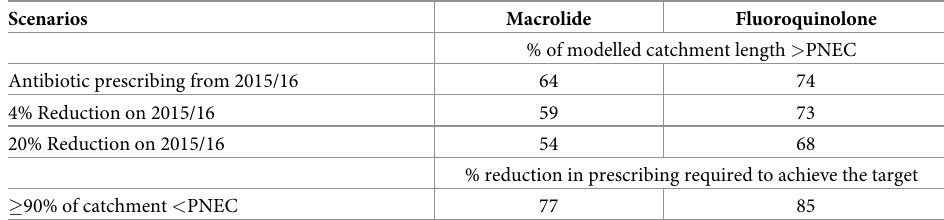
Table 9. Summary of the modelled impact of antibiotic prescribing on antibiotic resistance gene selection in sew- age-impacted freshwater.